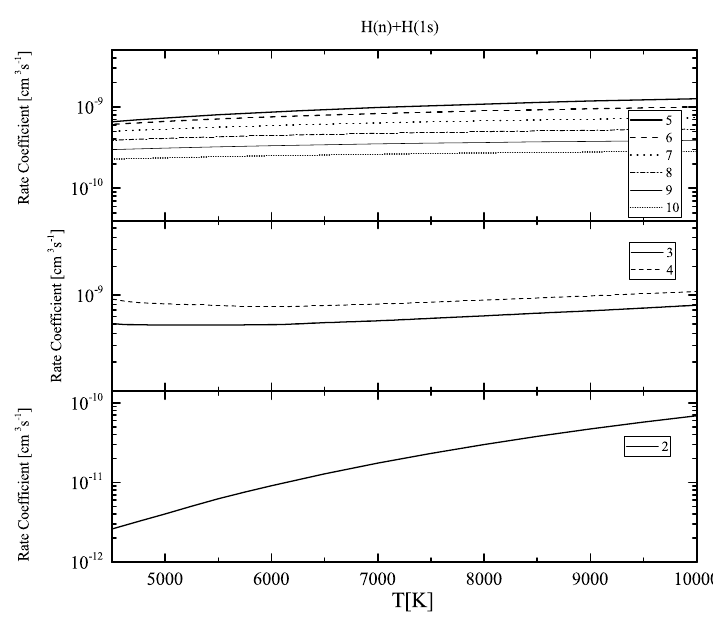
Figure 2. Plot of the rate coefficients for collisional ionisation H*( n ) + H(1 s ) (i.e., for chemi-ionization processes (1)) as a function of n and T .